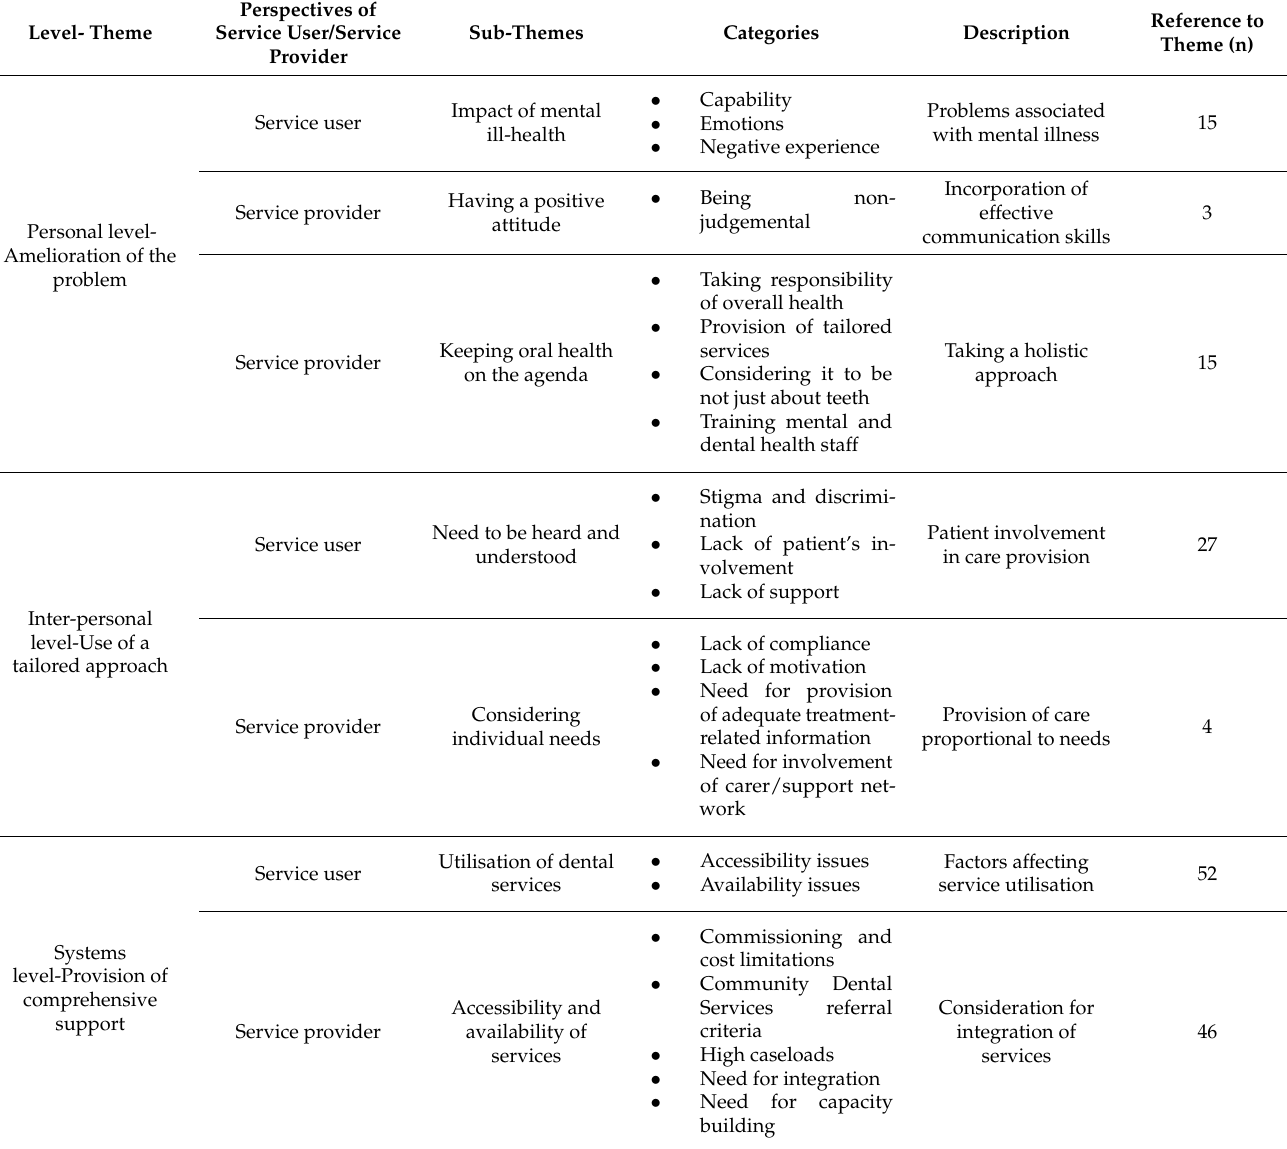
Table 2. Themes with associated levels, sub-themes and